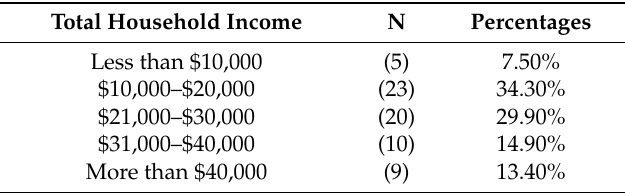
Table 3. Respondents’ Household Income.